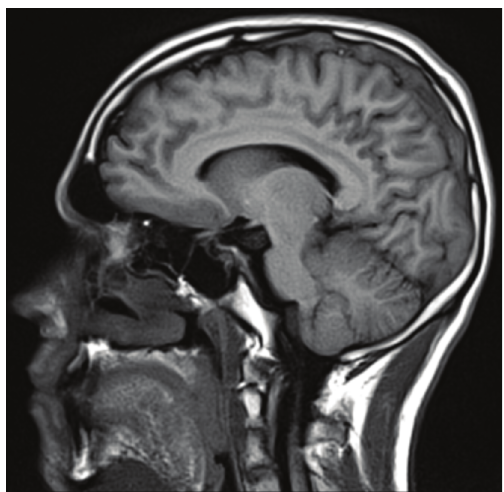
Figure 2: Sagittal T1 with superior longitudinal sinus